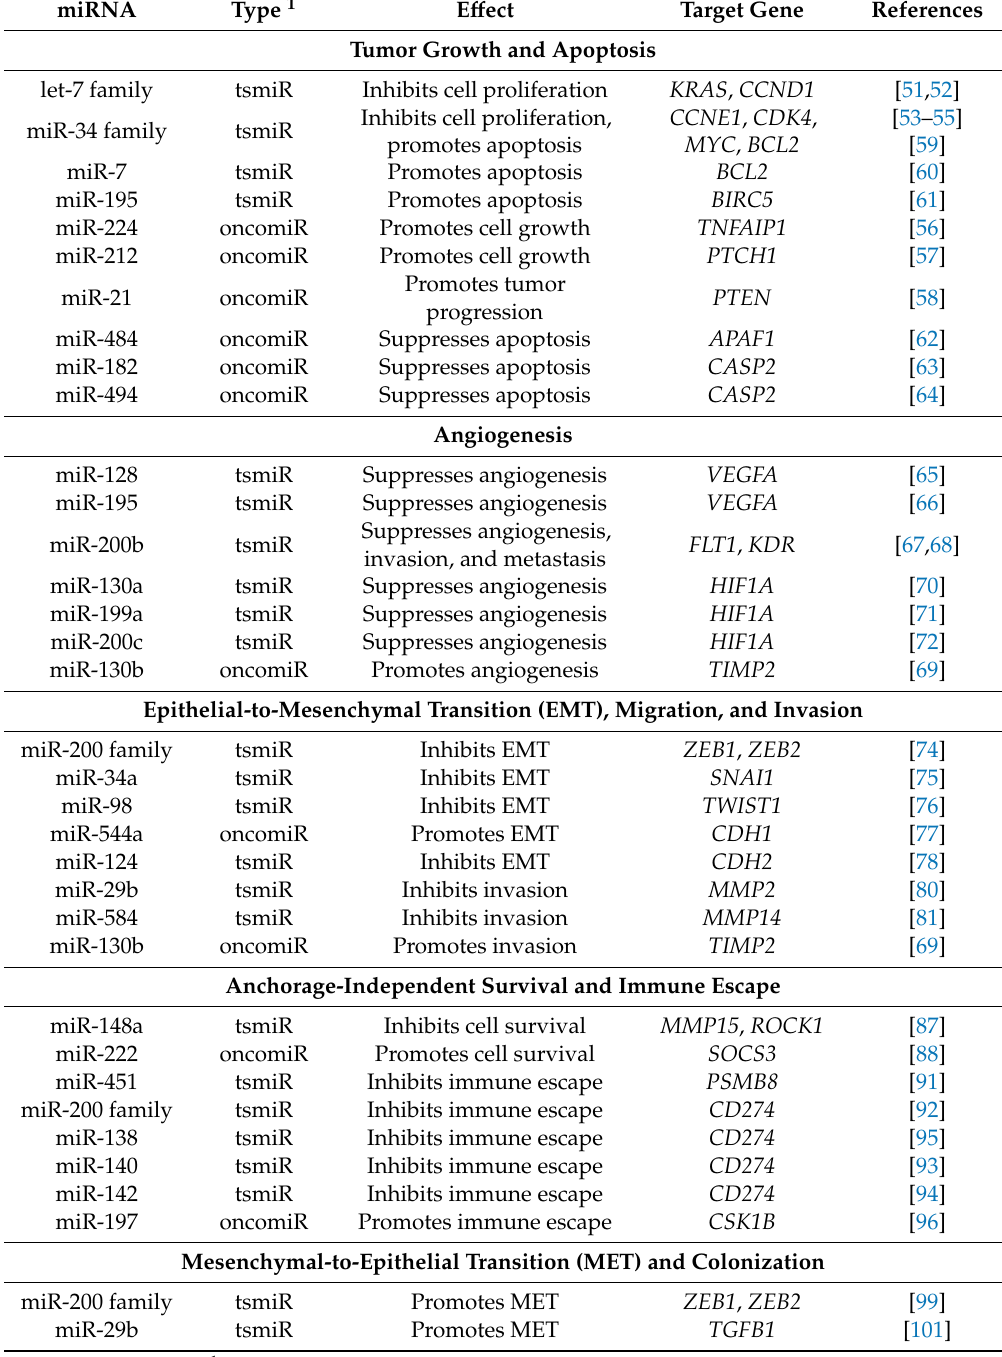
Table 1. miRNAs regulating progression and metastasis of non-small cell lung cancer.